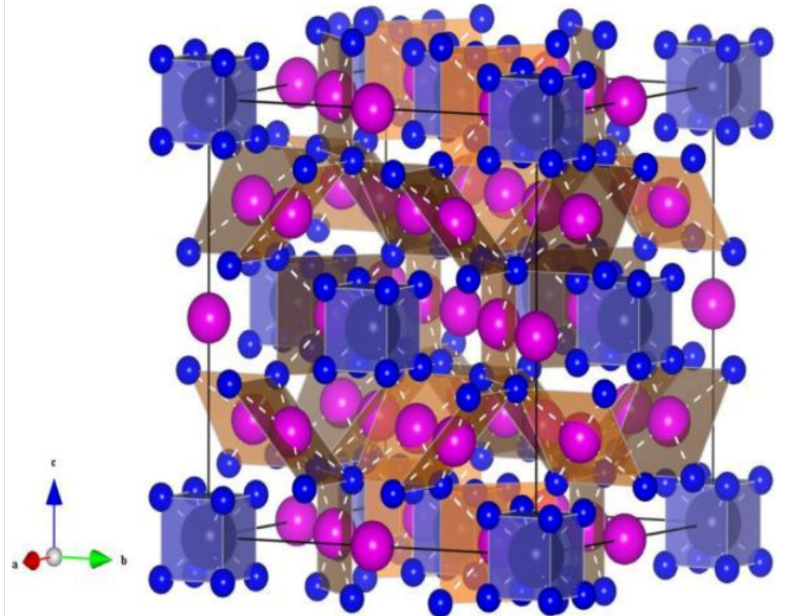
Figure 29. The high-pressure phase of Mg 7 TiH 16 crystal structure within an FCC structure anal- ogous to the Ca 7 Ge type with a unit cell of 96 atoms. Pink (medium), black (big), blue (small) spheres represent Mg, Ti, and H atoms, respectively. Reproduced with permission [228]. Copyright 2013, Elsevier.